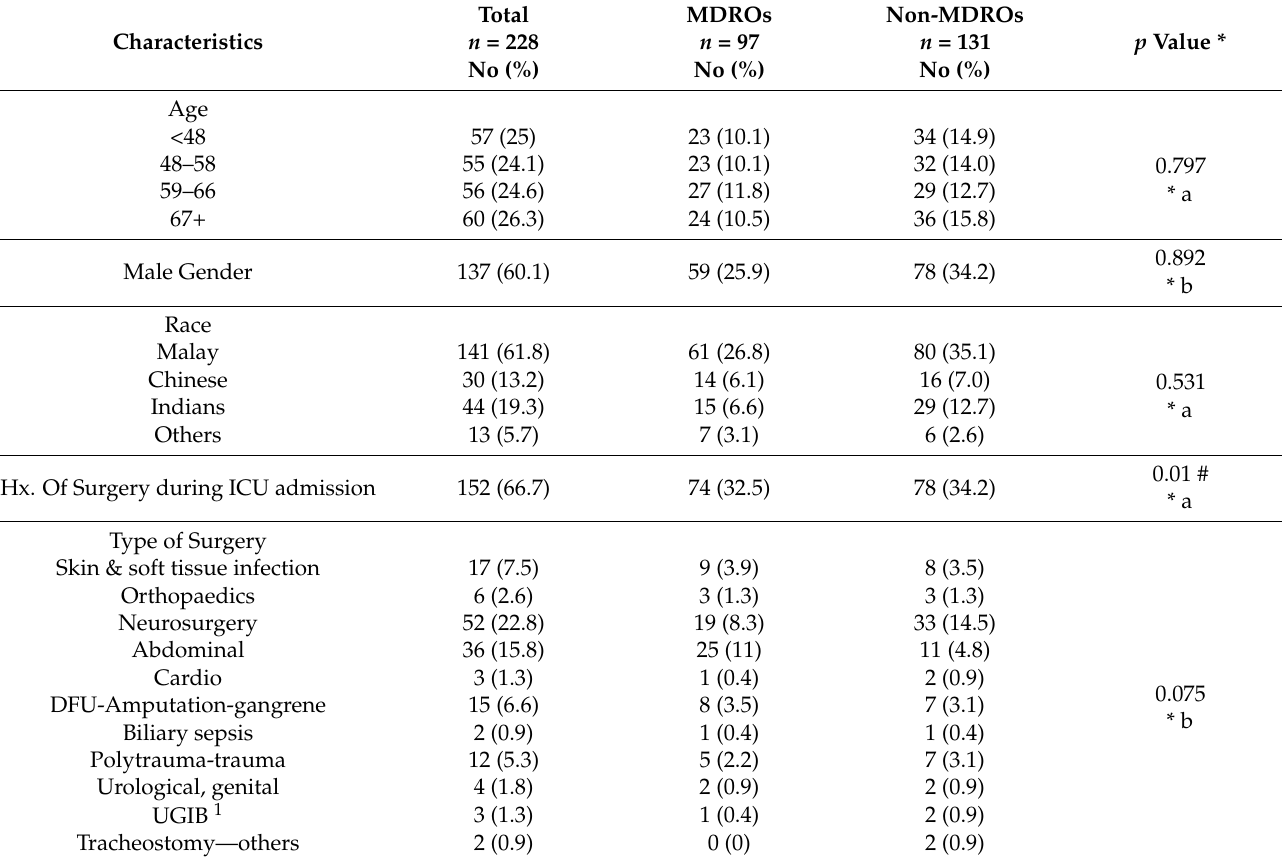
Table 2. Univariate association of baseline clinical characteristics and